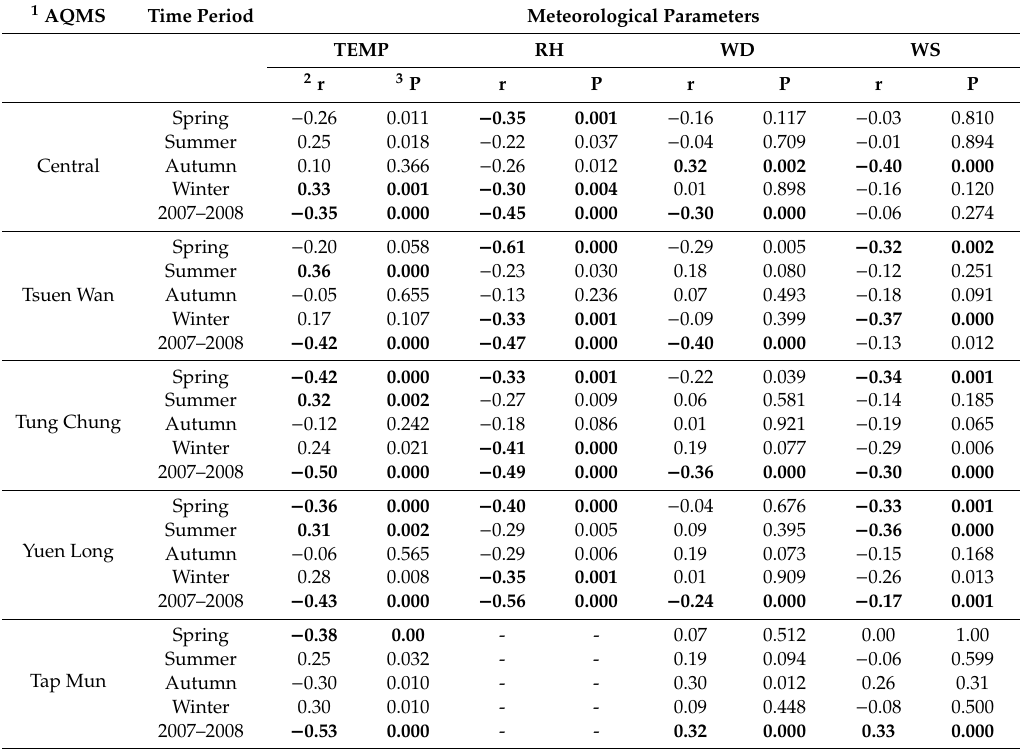
Table 4. Pearson’s correlation between daily mean PM 2.5 and meteorological parameters for the years 2007 and 2008. Bold text represents statistically more significant correlations for p -values < 0.005.